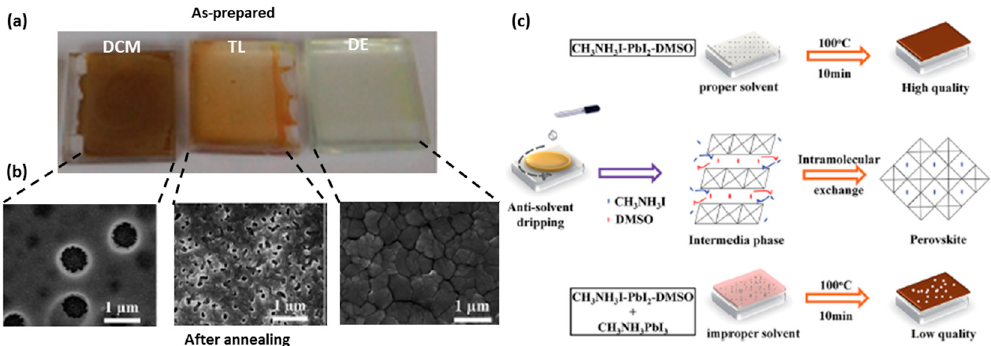
Figure 9. ( a ) Photographs of the as-prepared perovskite films using different anti-solvents. ( b ) SEM images of the same films after annealing. ( c ) Schematic illustration for the formation process of the perovskite films via the intermediate/anti-solvent approach. Reproduced from Ref. [65] with permission from Royal Society of Chemistry.